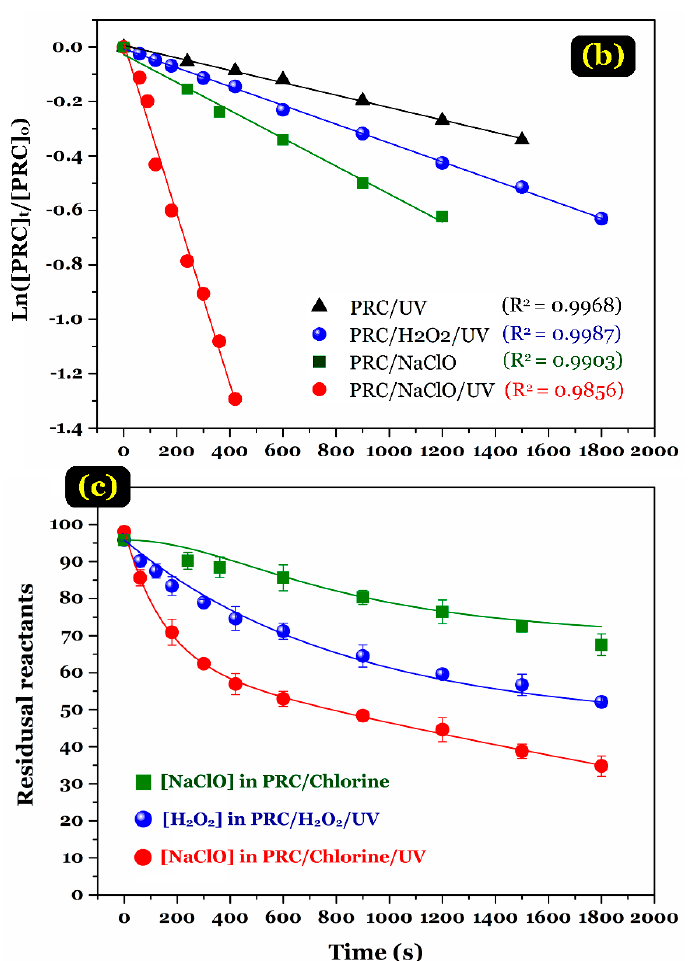
Figure 2. ( a ) Comparison of PRC degradation over time by the UV irradiation alone, UV/H 2 O 2 , chlorination alone, and UV/chlorine processes; ( b ) the plot of pseudo-first-order model (Experimental conditions: UV photon flux = 3.41 × 10 − 6 Einstein/s, [PRC] o ≈ 10 µ M, pH = 6.5, [NaClO] = 100 µ M, and [H 2 O 2 ] = 100 µ M); and ( c ) time-dependent profile of the residual reactants.